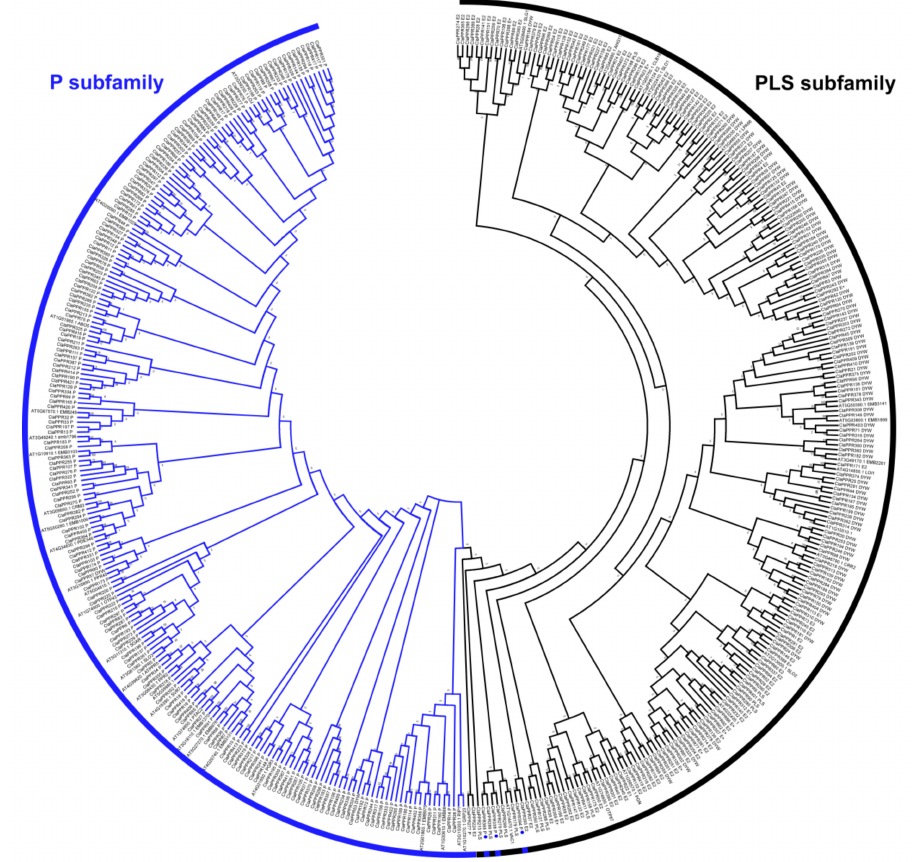
Figure 3. Phylogenetic relationships among the ClaPPR family genes. The full coding amino acid sequences of 422 ClaPPR proteins and 44 PPR proteins from Arabidopsis were aligned, and the NJ tree was built with 1000 bootstrap replicates using MEGA7.0. P; PLS subfamilies are represented using blue and black lines, respectively. P subfamily members which were clustered into the PLS subfamily members are indicated by a dot (blue)